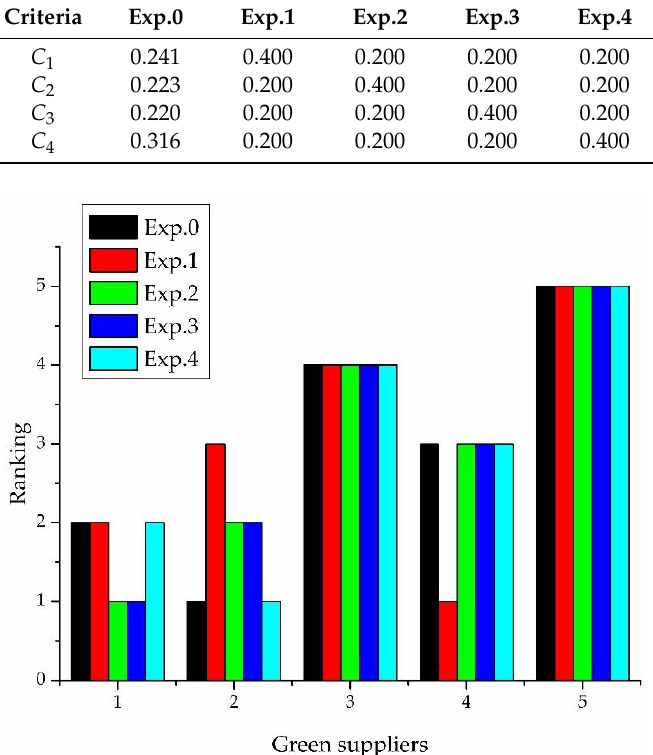
G changes significantly from one 2